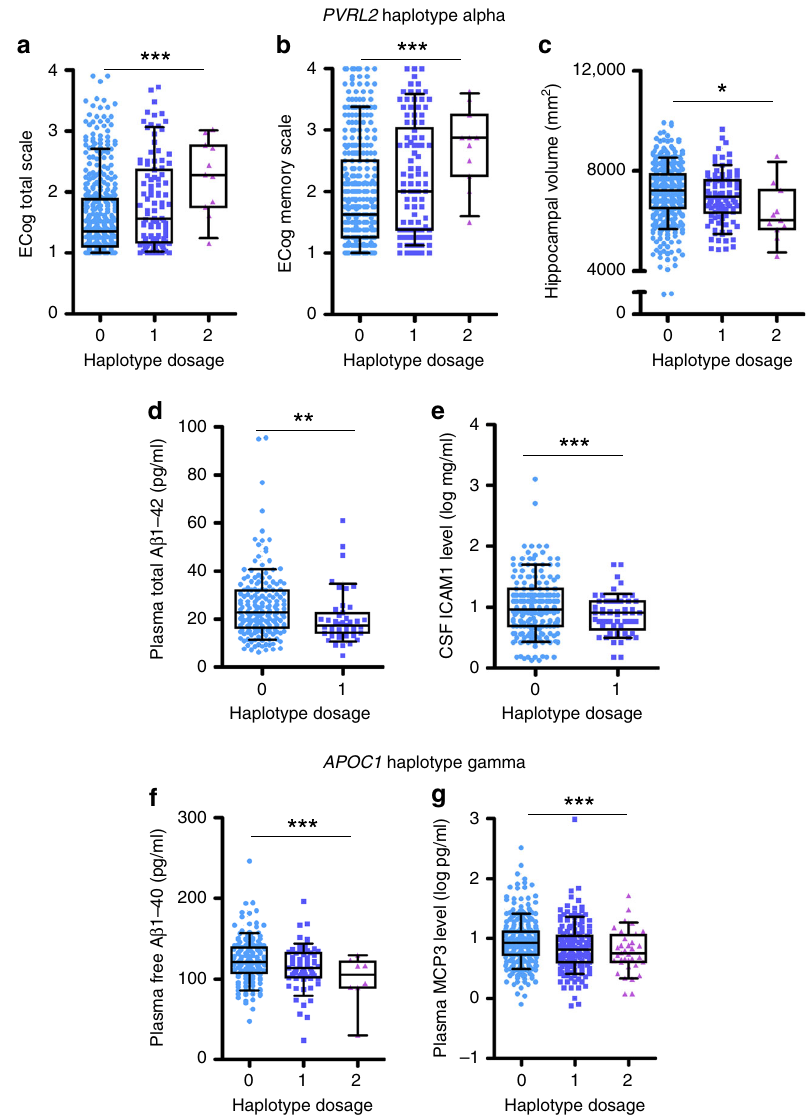
Fig. 4 Functional implications of PVRL2 and APOC1 haplotypes in an APOE - ε 4 – independent manner. a – e . Associations between PVRL2 minor haplotype alpha, and cognitive performance and biomarker expression in an APOE- ε 4-independent manner. a , b Associations between PVRL2 alpha haplotype dosage with ( a ) cognitive performance indicated by total ECog score (scored between 0 − 4; higher scores represent more severe disability in functioning) reported by study partners ( n = 527, T = 3.71, *** p < 0.001, Beta = 0.25) and ( b ) memory performance indicated by ECog memory score reported by study partners ( n = 527, T = 3.60, *** p < 0.001, Beta = 0.29). c Association between PVRL2 alpha haplotype with hippocampal volume ( n = 1,121, T = − 2.31, * p < 0.05, Beta = − 165.60 [mm 2 ]). d , e Associations between PVRL2 alpha haplotype with ( d ) total A β n = 226, T = − 3.098, ** p < 0.01, Beta = − 4.113 1 – 42 in plasma ( [pg/mL]) and ( e ) ICAM-1 in cerebrospinal fl uid; n = 298, T = − 3.361, *** p < 0.001, Beta = − 0.199 [log ng/mL]). Individuals harboring two copies of haplotypes were not included due to the small samples size. f , g Association between APOC1 gamma haplotype with levels of ( f ) plasma free A β 1 – 40 ( n = 226, T = − 4.823, ** *p < 0.001, Beta = − 40.231 [pg/mL]) and ( g ) plasma MCP3 (CCL7) ( n = 537, T = − 3.665, ** *p < 0.001, Beta = − 0.229 [log ng/mL]). A β amyloid-beta, ECog everyday cognition. Data are presented in box plots, with boxes extending from the 25th to 75th percentiles and whiskers specifying the 10th and 90th percentiles; the line in the middle of the box denotes the